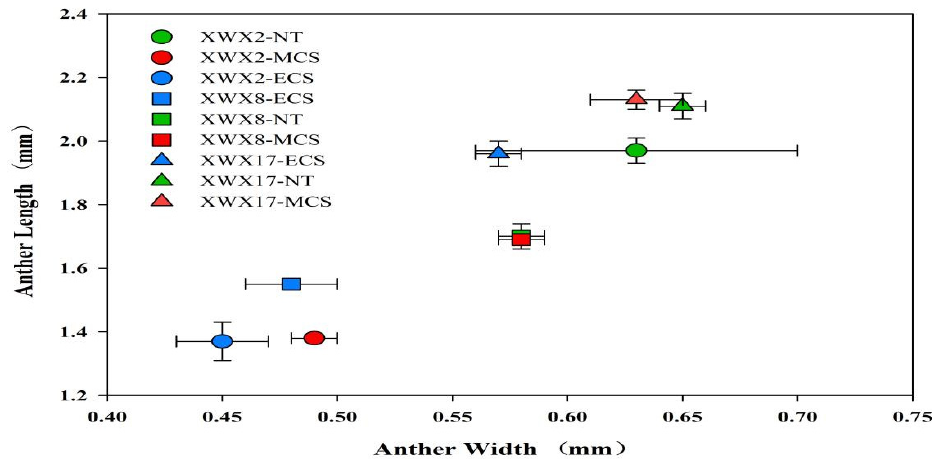
Figure 4. The anther length and anther width of three inbred late varieties under different temperature treatments. XWX2: Xiangwanxian2; XWX8: Xiangwanxian8; XWX17: Xiangwanxian17; NT: Normal temperature control; MCS: Moderate chilling stress; ECS: Extreme chilling stress.